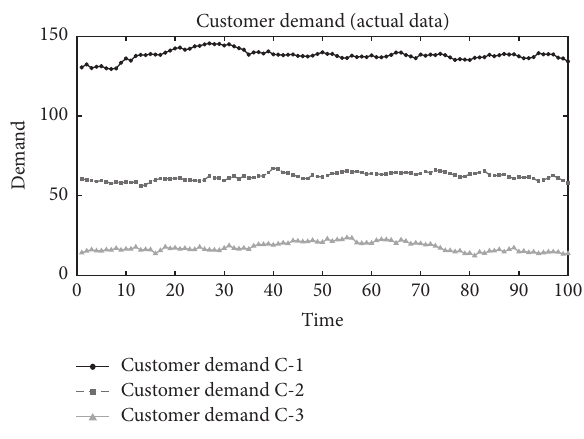
Figure 4: Simulated base customer demands.